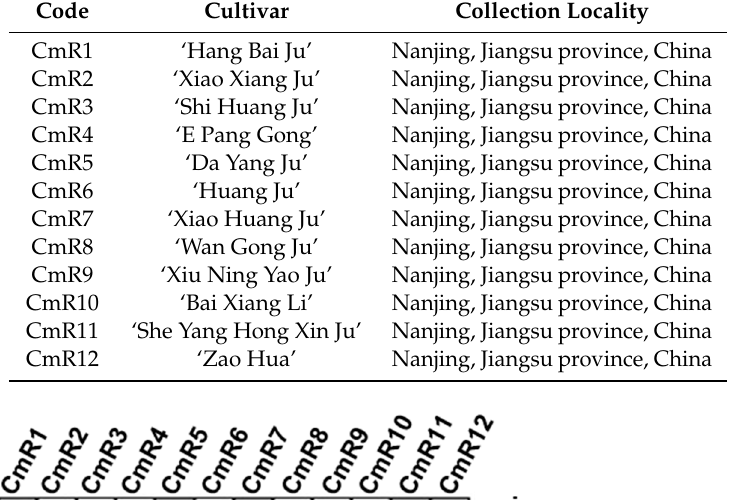
Table 1. Cultivars of C. morifolium used in this study.